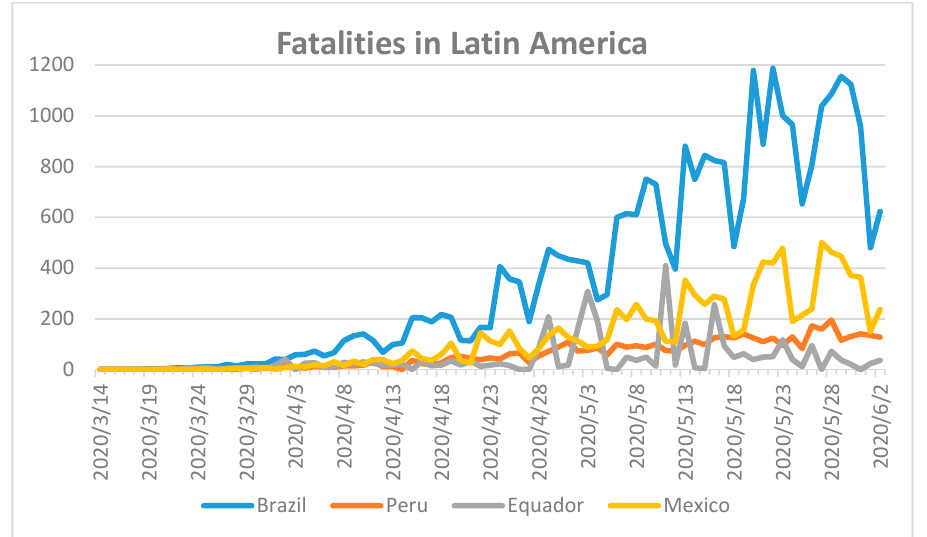
Figure 7. Fatalities during COVID-19 in Latin America until 2 June 2020 [18]. First fatality in Brazil on 18 March, Peru on 20 March, Ecuador on 14 March, and Mexico on 24 March 2020.